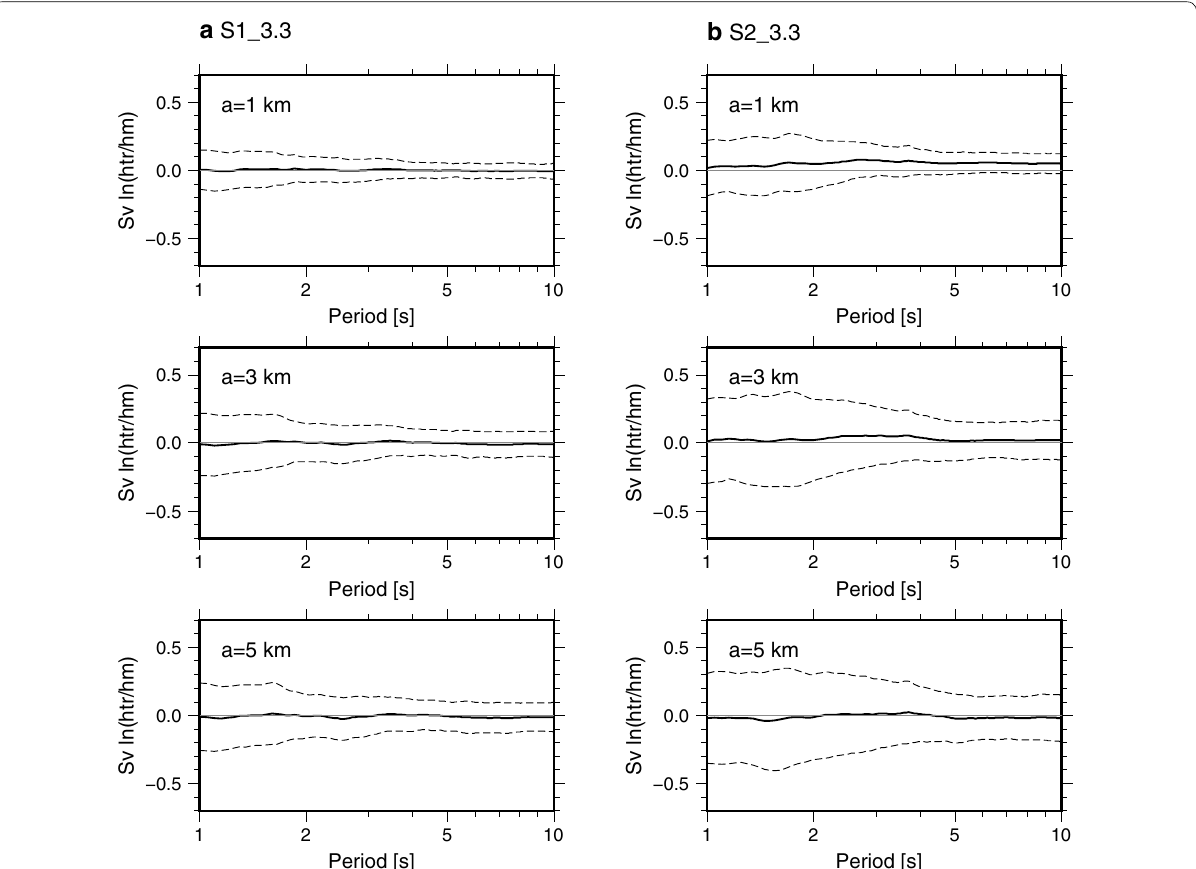
Fig. 10 Model bias of the heterogeneous model from the homogeneous model for response spectra. Heterogeneous-to-homogeneous ratio of 5% damped velocity response spectra for the heterogeneous velocity models with a (K-NET and KiK-net stations; see Fig. 1) and five realizations at each period points, for source models a S1_3.3, b S2_3.3. Standard deviation is plotted by dashed